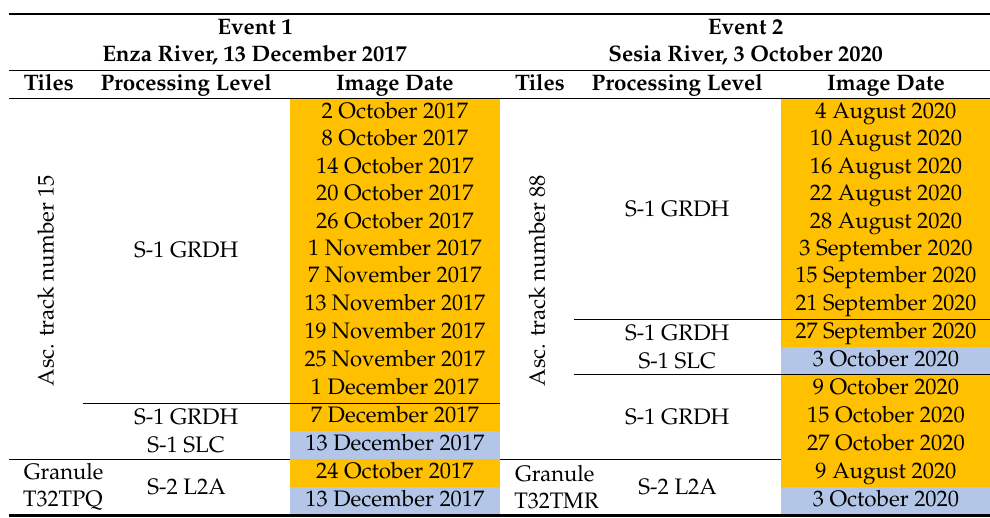
Table 1. Dates of GRDH Sentinel-1 (S-1), SLC S-1, and Sentinel-2 (S-2) data used. The explanation of the data products can be found in the text above. The flood and non-flood images are represented in blue and orange color respectively. The footprints of the images are also shown in Figure